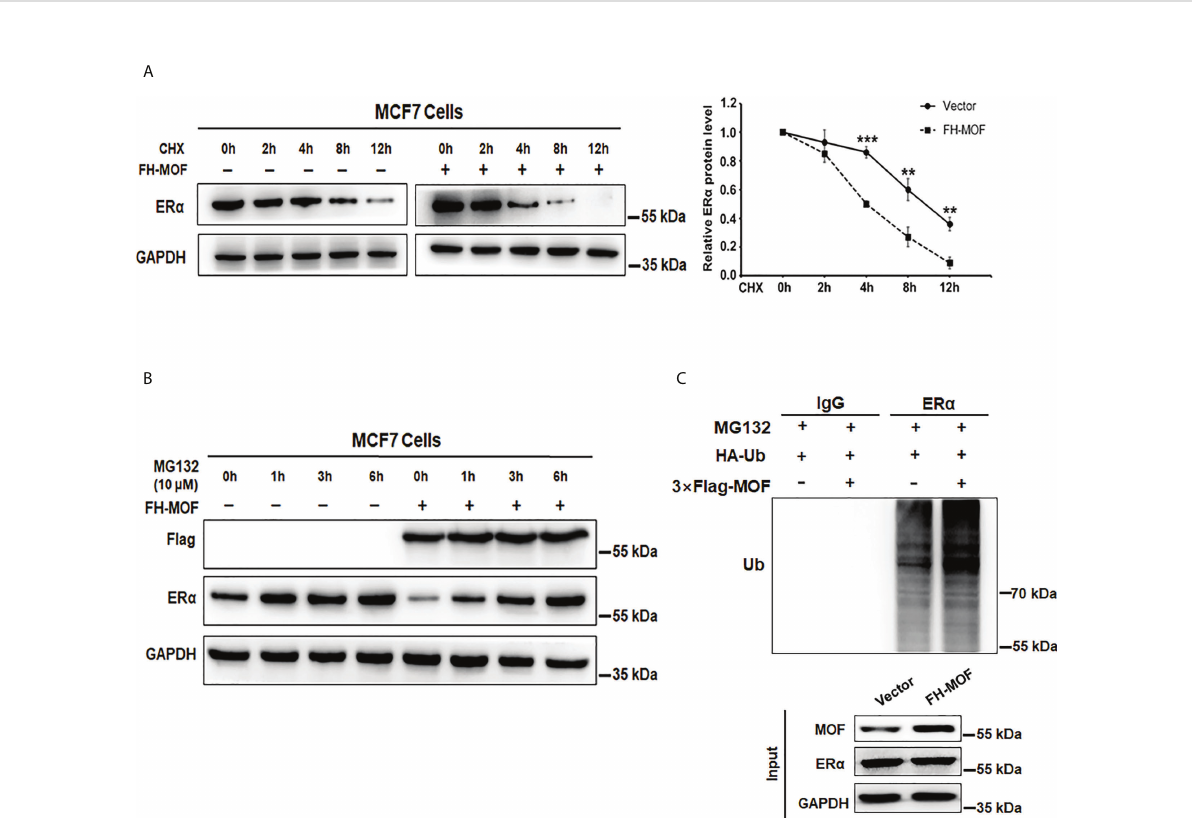
FIGURE 4 MOF promotes ER a protein degradation via ubiquitin – proteasome pathway. (A) CHX (10 m g/ml) assay was performed to examine the protein degradation of ER a under MOF overexpression. CHX (10 m g/ml) was applied for MCF7 cells with FH-MOF or control transfection, and cells were terminated at speci fi ed time points to calculate the half-life of ER a protein. (B) Proteasome inhibitor MG-132 could prevent ER a protein degradation induced by MOF overexpression. (C) Co-IP assay was performed in the presence of MG-132 to detect the polyubiquitin-conjugated ER a protein level in Flag-MOF – transfected cells. ***P < 0.001 and **P < 0.01 vs. control